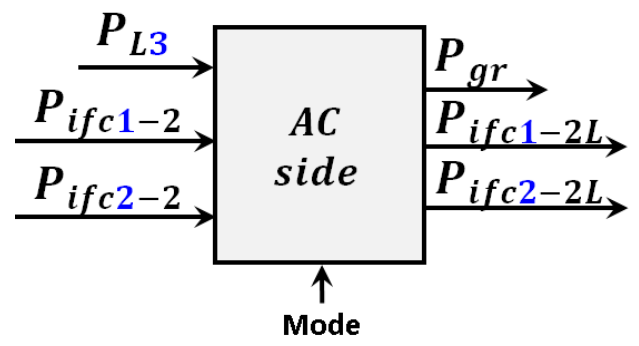
Figure 8. Block diagram of the programmed model of the AC side.